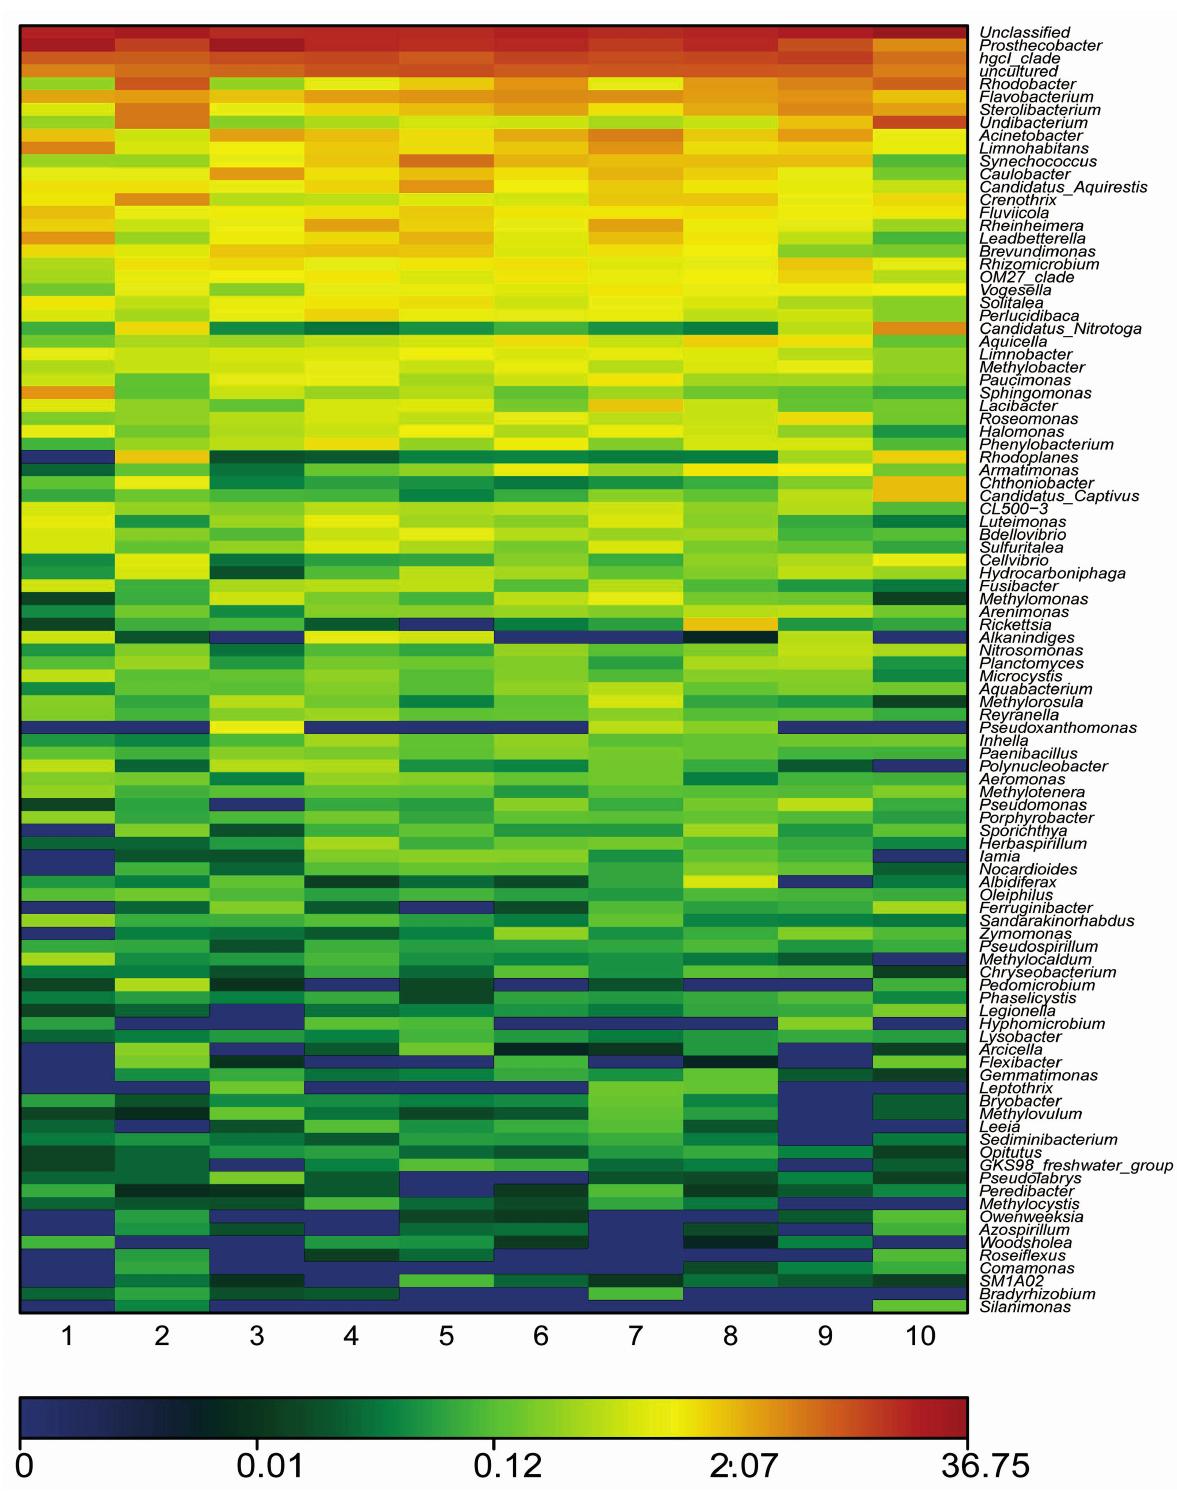
Figure 4. A color-scale heat map showing the top 100 representative predominant 16S rRNA gene-based bacterial sequences classified at the genus level. Red colors indicate higher abundance; blue and green colors indicate lower abundance. 1, 2, 3, 4, 5, 6, 7, 8, 9, and 10 represent 0.5, 5, 10, 20, 25, 30, 45, 50, 55, and 65 m depths,